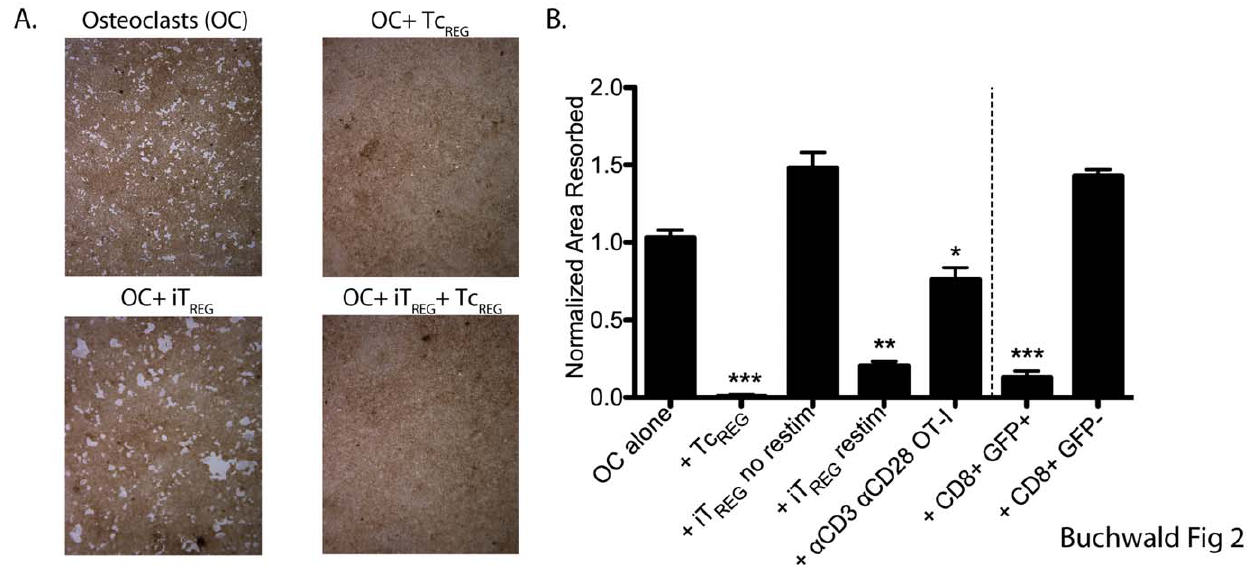
Figure 2. TcREG inhibit osteoclast resorption. A. Osteoclasts (day 3) lifted and plated on hydroxyapatite-coated plates. OT-I Tc REG or OT-II TGF b - induced FoxP3 + CD4 T-cells (iT REG ) generated in separate dishes were added next day. The co-cultures were re-fed every two days. After seven days, the wells were treated with bleach, photographed, and total pit area was quantified (results in panel B). Representative images from five replicates are shown in panel A . No pitting was observed in the presence of Tc REG (top right). Larger pits were observed in the presence of iT REG (bottom left), but Tc REG were dominant suppressors (bottom right). B . Tc REG suppressed pitting on hydroxyapatite plates without re-stimulation. In contrast, iT REG could only suppress after re-stimulation (see methods for details). IFN- c producing OT-I T-cells activated by anti-CD3 and anti-CD28 in the presence of IL-2 could partially suppress pitting by osteoclasts. Activated GFP + CD8 T-cells purified by cell sorting from FoxP3 eGFP reporter mice could also suppress osteoclast pitting, while conventional (GFP 2 ) CD8 had no affect on pitting. Statistical significance of area resorbed was assessed by Wilcoxon test: *: P , 0.05, **: P , 0.01 and ***: P , 0.001 relative to osteoclast alone wells.